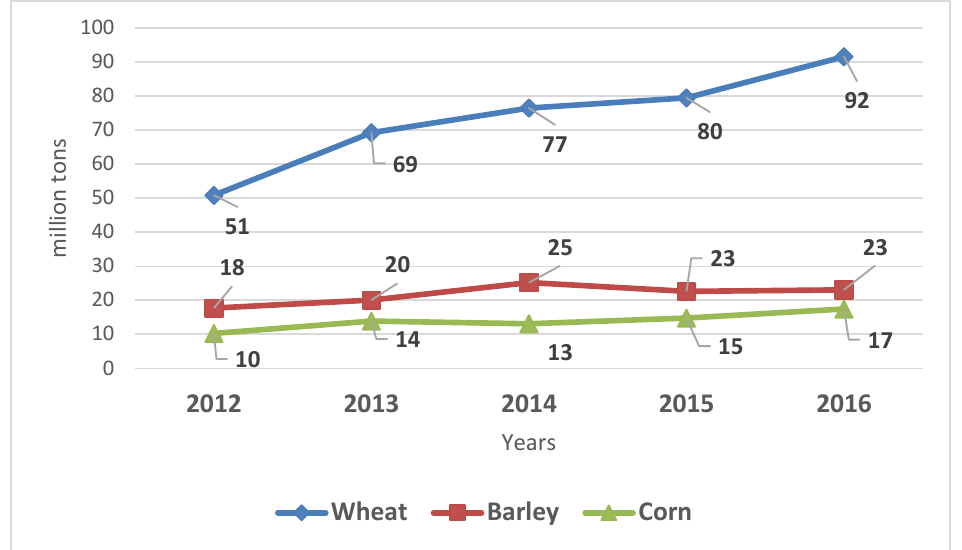
Figure 1. Gross collections of wheat, barley, and corn for the grain and volume production in the EAEU countries from 2012 to 2016, in million tons. Compiled from the statistical services of the EAEU countries [20–24].